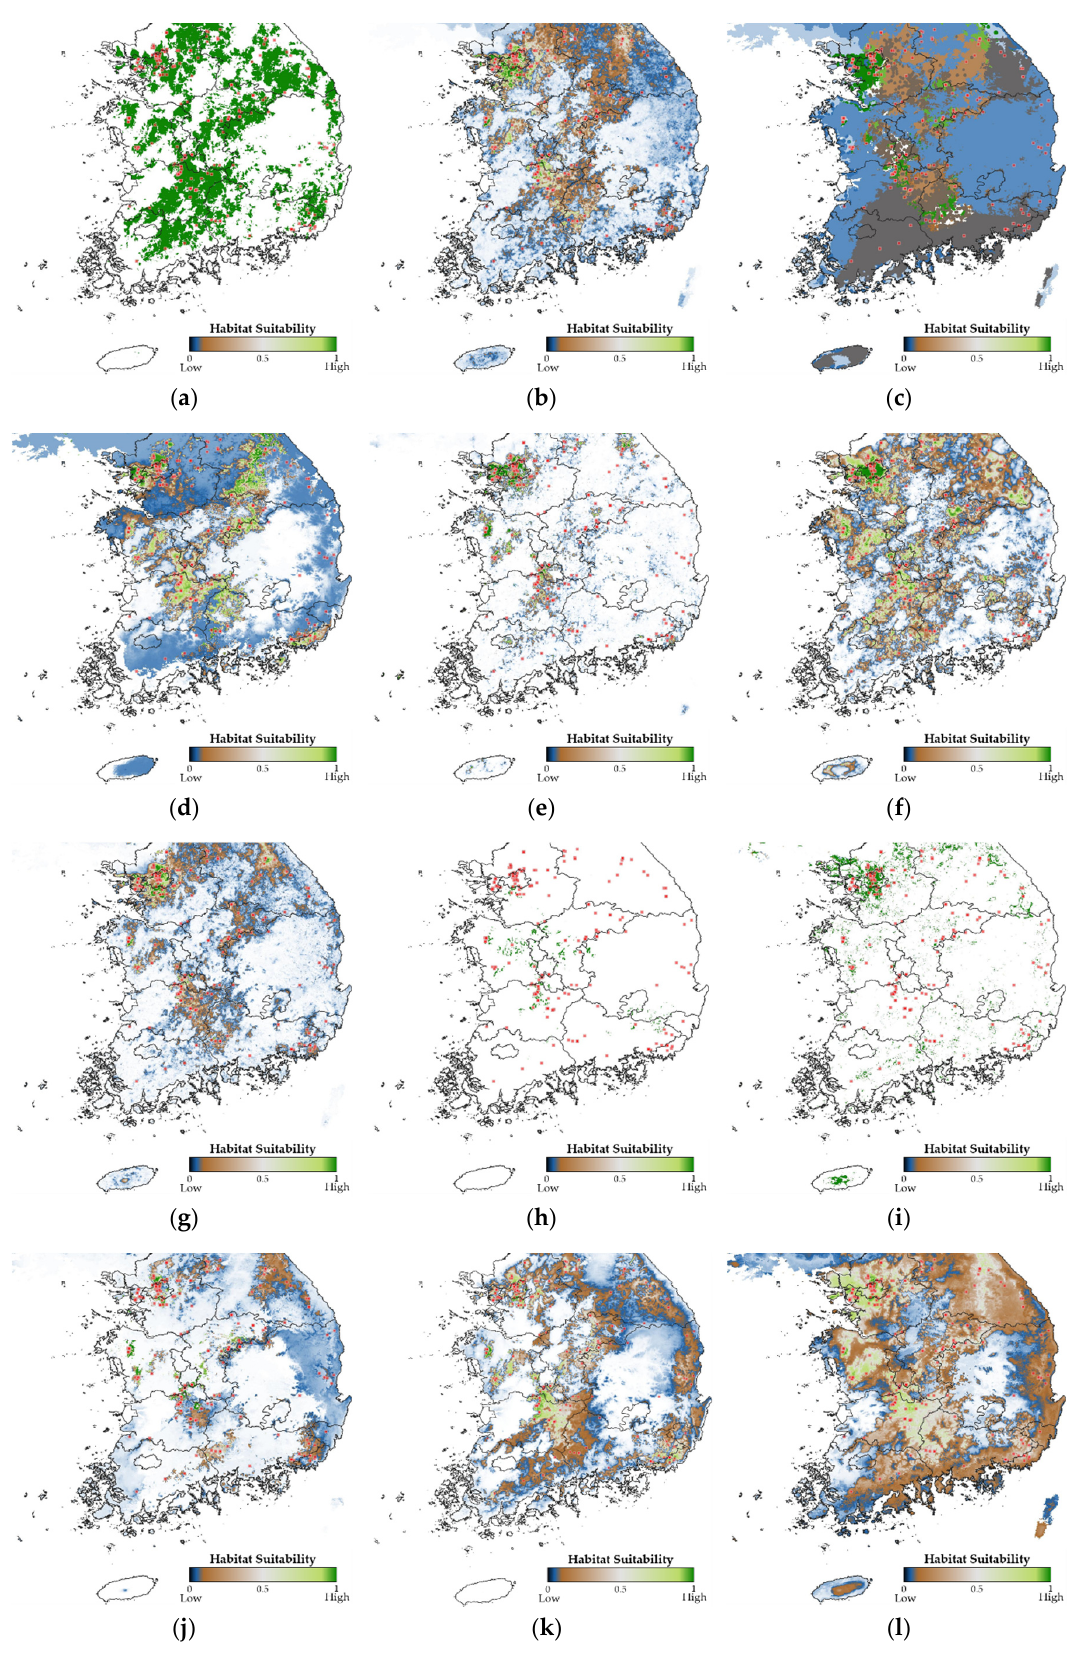
Figure 6. Habitat suitability visualization of Rana huanrenensis–( a ) GLM; ( b ) GBM; ( c ) CTA; ( d ) SNN; ( e ) FDA; ( f ) MARS; ( g ) RF; ( h ) SRE; ( i ) MAXENT; ( j ) DNN; ( k ) EMED; ( l ) TSEM.